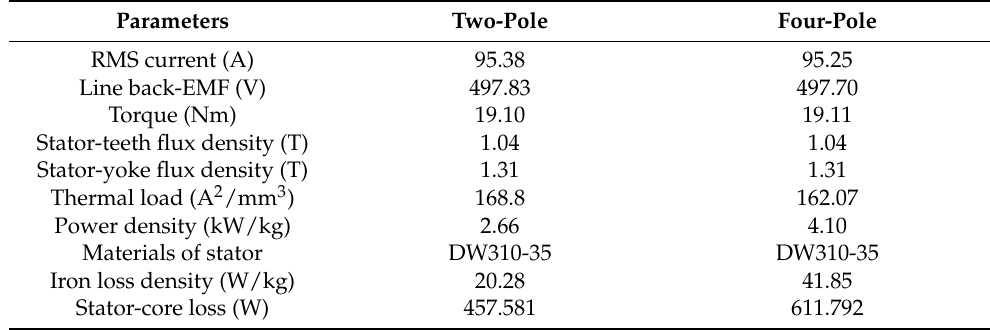
Table 5. Electromagnetic characteristics comparison of two-pole motor and four-pole motor for HSPMM under rated